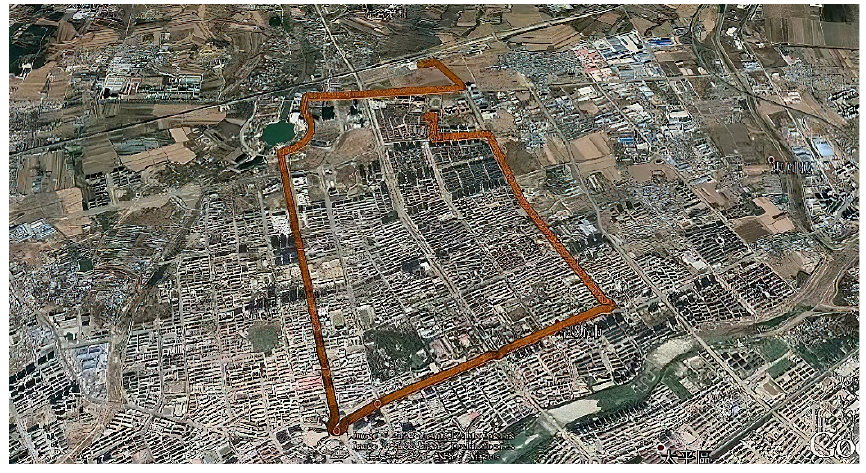
Figure 6. Test track diagram .